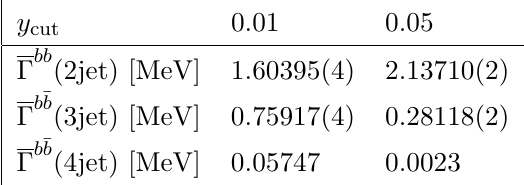
Table 5. The total jet rates at NNLO for (cid:22) R = M H using the Durham clustering algorithm with y cut = 0 : 01 and y cut = 0 : 05, including the y b y t